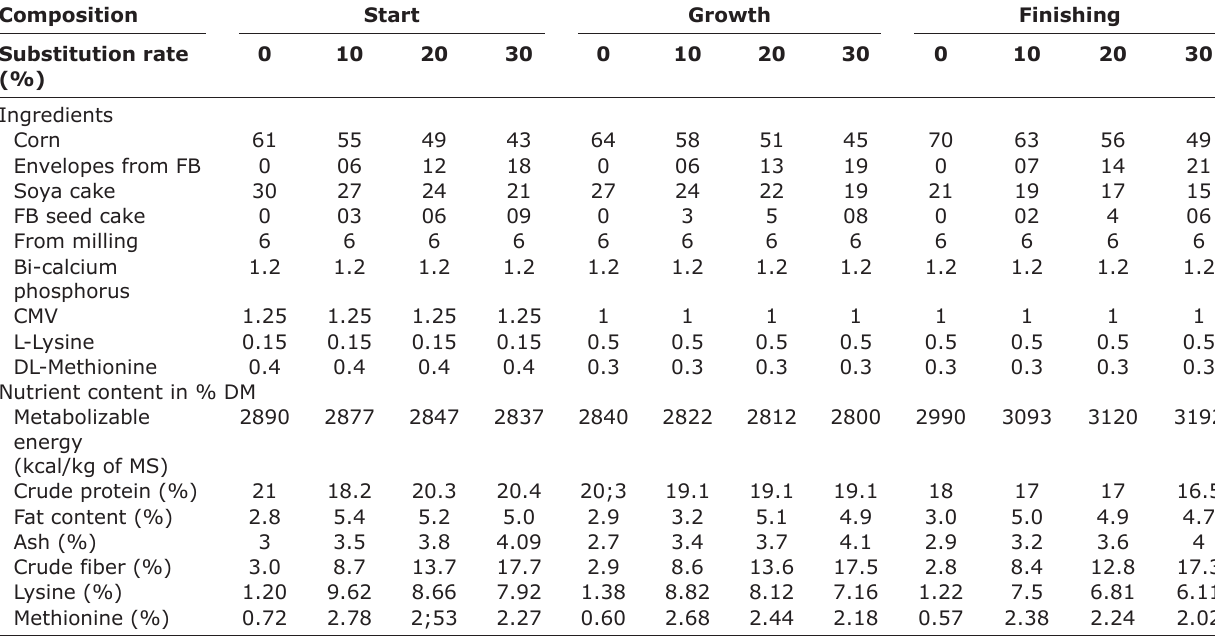
Table-2: Formulas (kg/100 kg feed) of starter (1-20 days), grower (21-33 days), and finisher (34-48 days) feed distributed to chickens according to the rate of substitution of corn by prickly pear (FB) husks and soybean meal by FB seed cake.